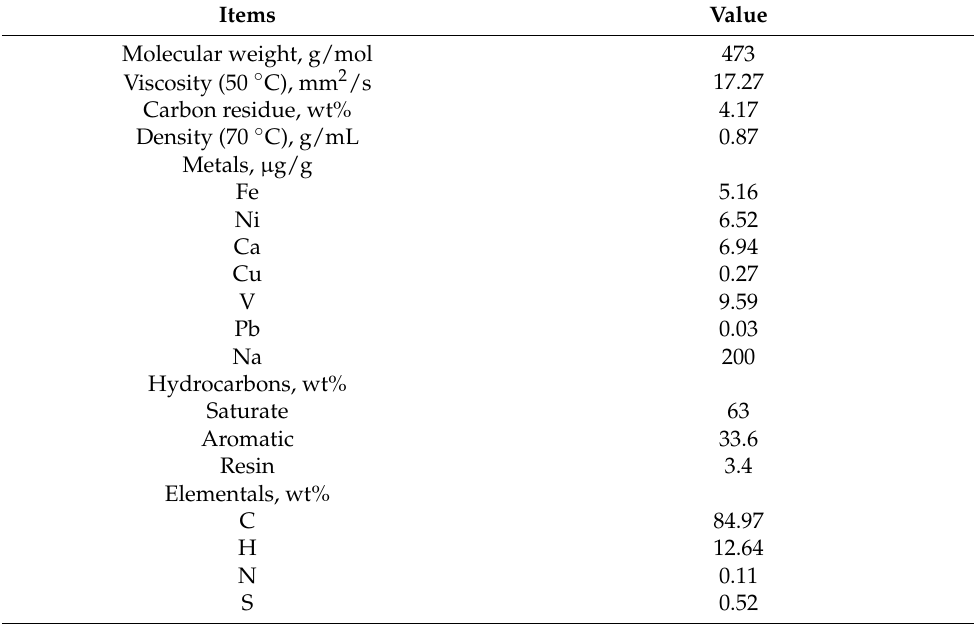
Table 1. Properties of heavy oil.